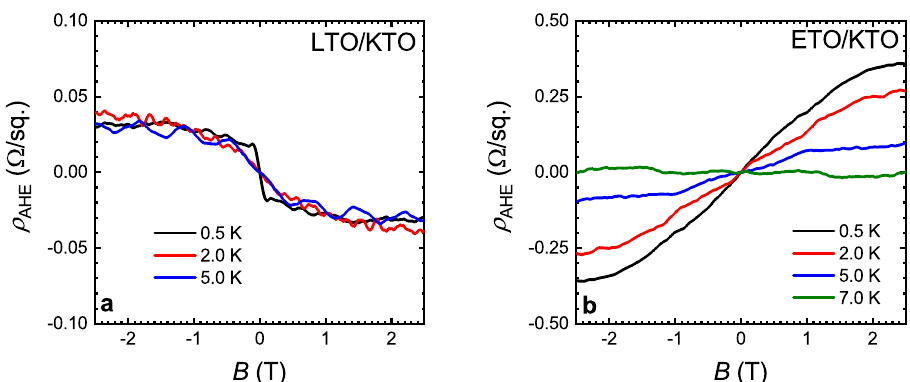
Fig. 5 Anomalous Hall effect. Anomalous Hall resistivity for LTO/KTO is plotted in ( a ) and that for ETO/KTO is plotted in ( b